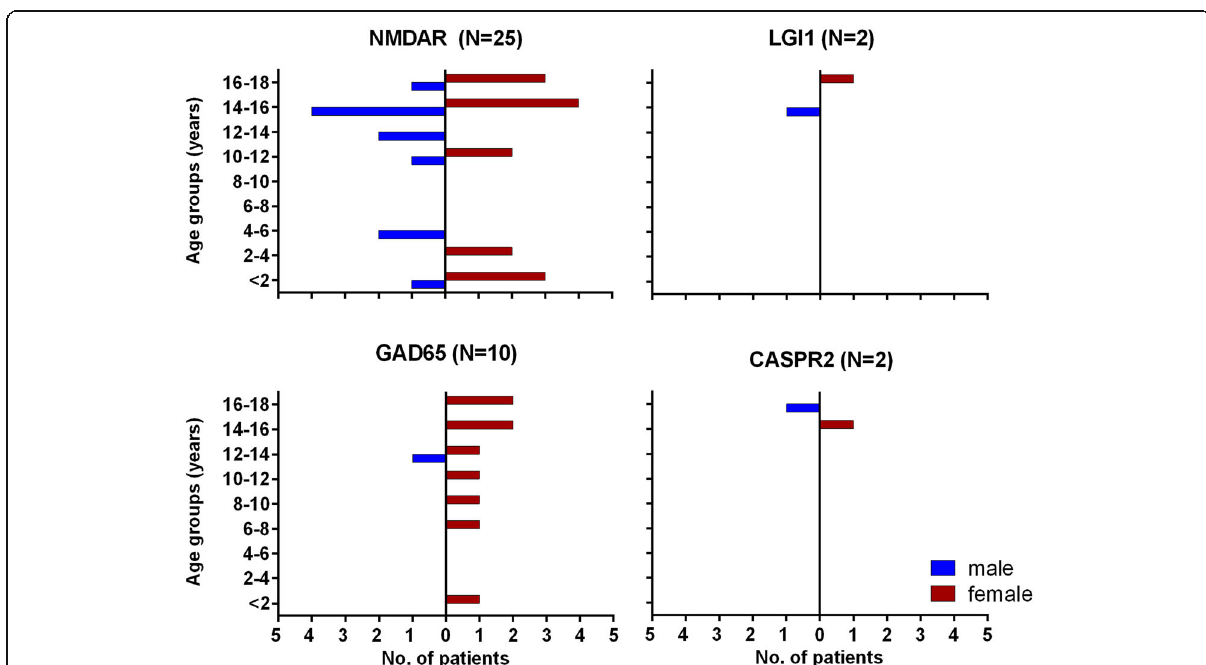
Fig. 2 Age and sex distribution of antibody-positive patients. Males: blue; females: red. The patients with GAD65 antibodies are predominantly female, whereas in the other groups, the relationship is equal, even with NMDAR antibodies (56% female). Only one girl (4% of all patients with NMDAR antibodies) had paraneoplastic disease with an ovarian teratoma. The figures in a recent Chinese pediatric study were: 61% females ( N = 54), one case with ovarian teratoma (1.1%) [28]. One pediatric series from the US ( N = 32) had different results: The authors found 81% female patients and 25% paraneoplastic cases [25]. One reason seems to be that African-American patients particularly frequently have paraneoplastic anti-NMDAR encephalitis